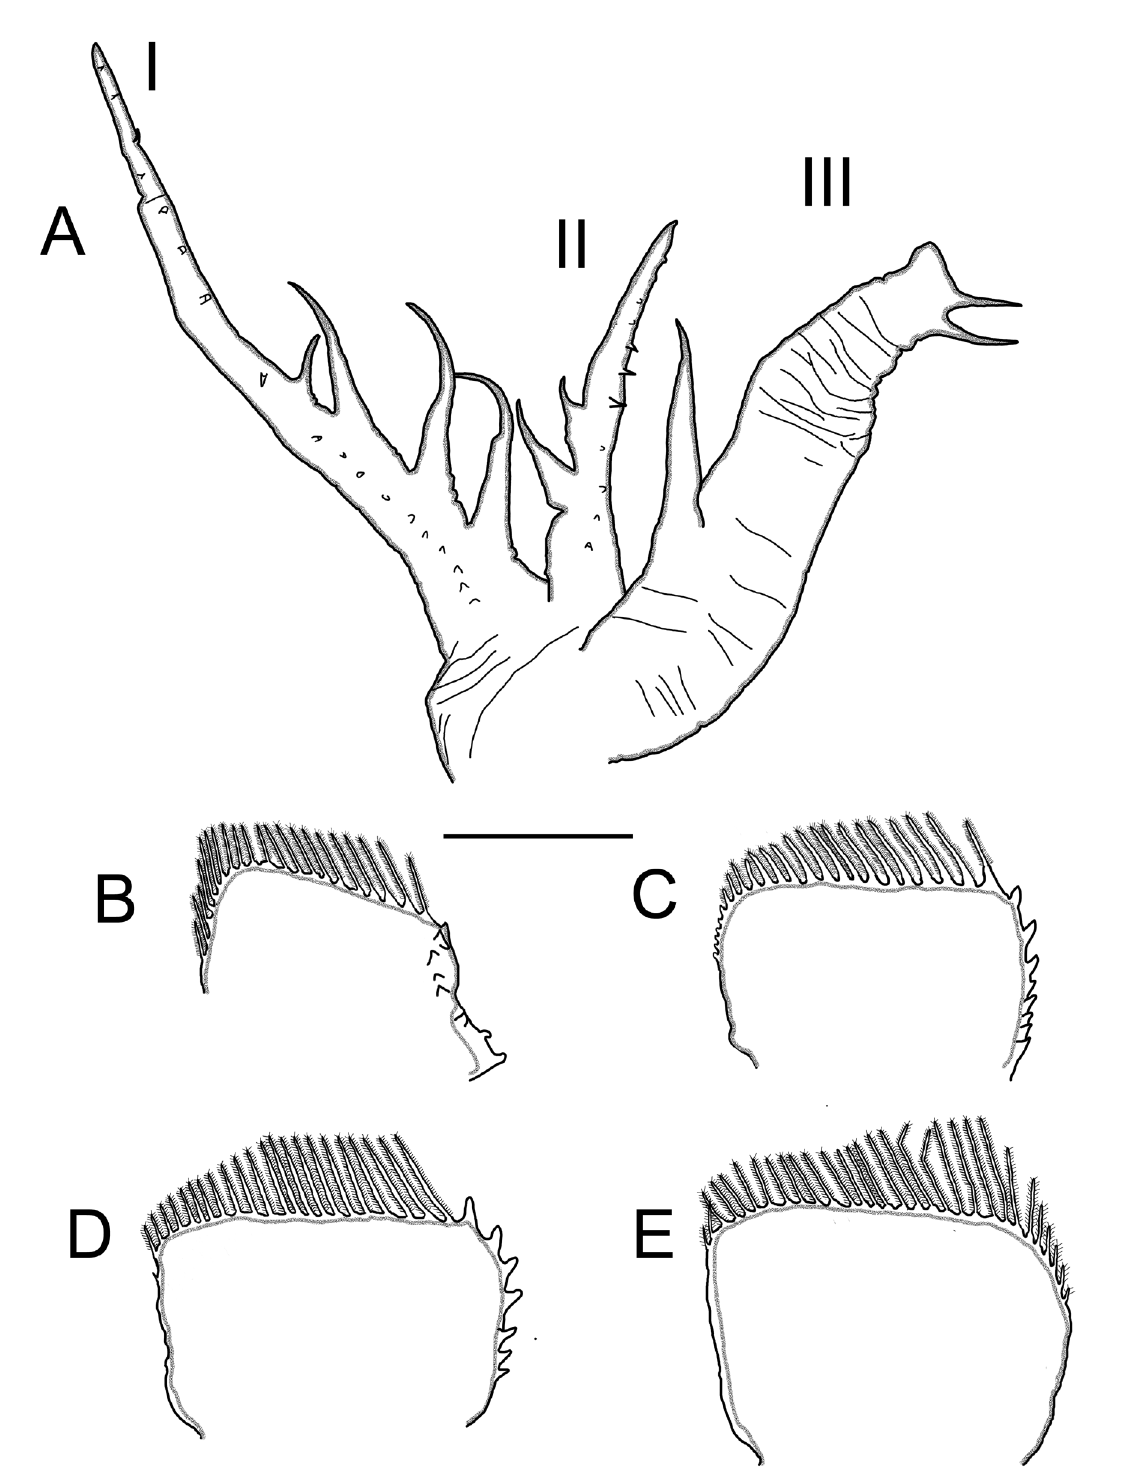
Fig. 6 . Dendrocephalus xikrini Rabet & Bozelli sp. nov., ♂. A . Branch 2D of the frontal appendage. B . Endopodite of the first limb. C . Endopodite of the second limb. D . Endopodite of the third limb. E . Endopodite of the fourth limb. Scale bar: